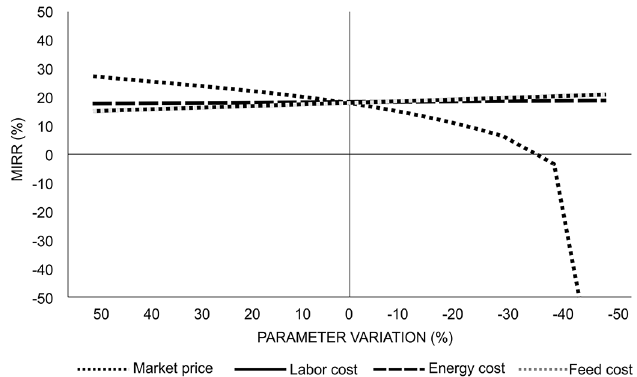
Fig. 4. Sensitivity analysis with (cid:1) 50% to 50% variation in four parameters and its effect on the Modi fi ed Internal Return Rate. Note : Labor and feed cost have a similar effect on the MIRR and they seem to overlap in the fi